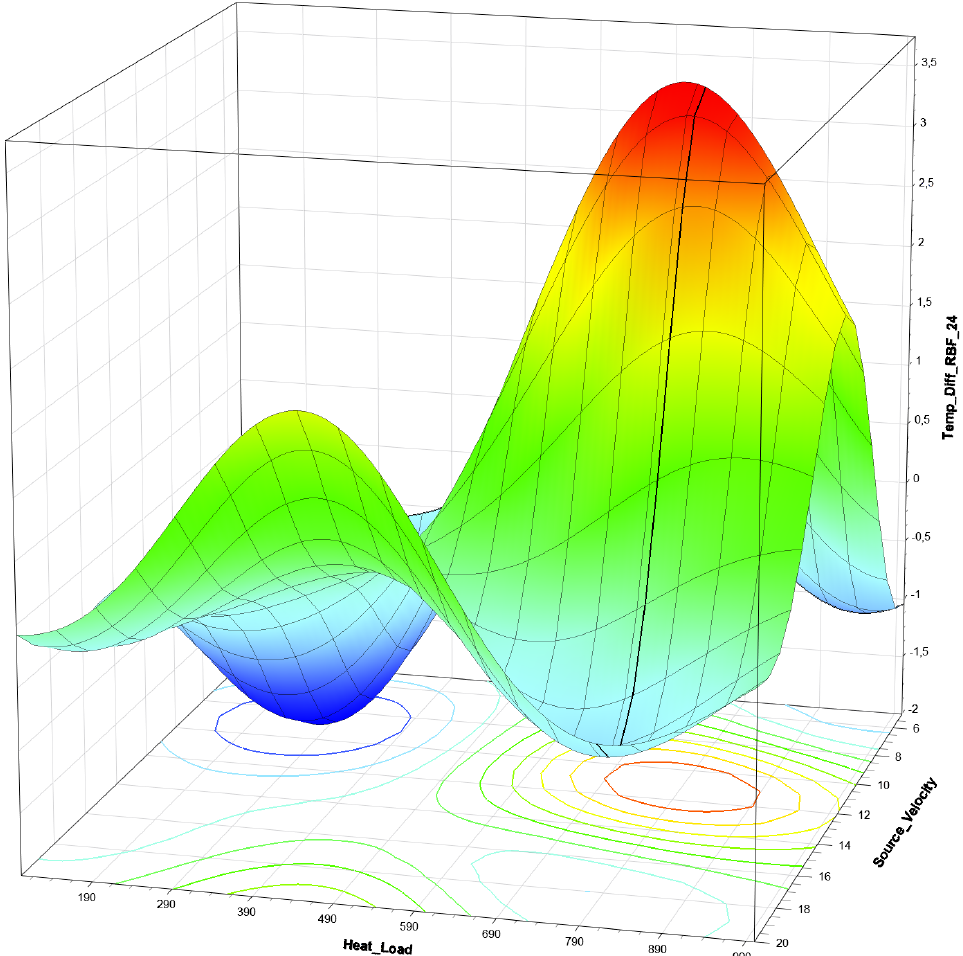
Figure 7. A simplified 3D response surface extracted from the eight dimensional response surface created using 1000 DLST simulations. An approximation has been composed visualising the influence of the source velocity [mm/s] and the heat load [W] on the contrast above the defect [ ◦ C]. The following values are used for the remaining parameters: d heat − cam = 425 mm, d start = 5.8 mm, D hole = 9 mm, d height = 430 mm, T ambient = 48 ◦ C. An ambient temperature of 48 ◦ C is